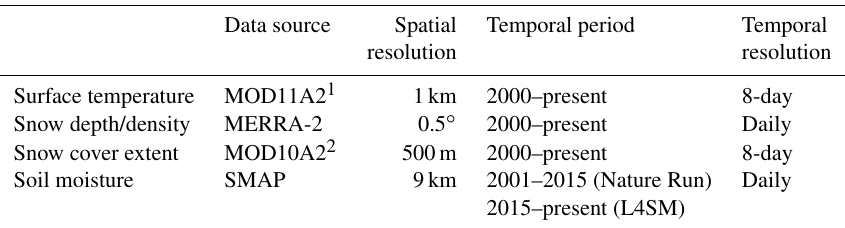
Table 1. Geospatial datasets used as primary inputs for the soil process model over